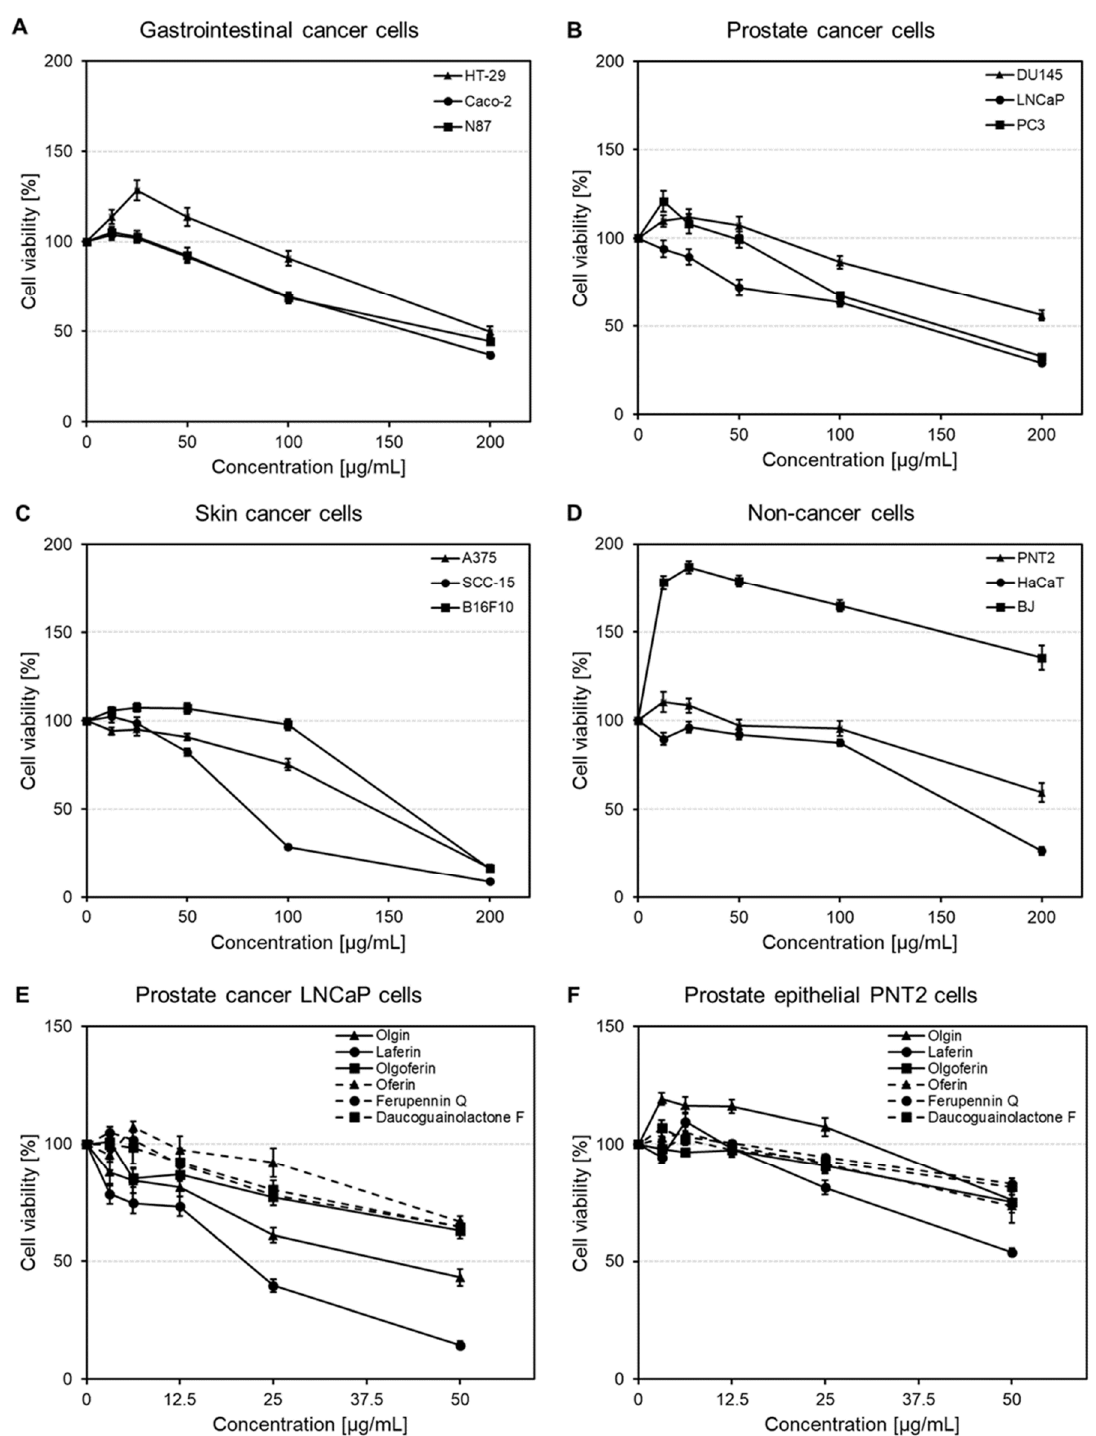
Figure 4. Concentration-response curves showing the effect of Ferula penninervis methanolic root extract against gastrointestinal cancer cells ( A ), prostate cancer cells ( B ), skin cancer cells ( C ) and non-cancer cells ( D ) and the effect of isolated sesquiterpene lactones against prostate cancer LNCaP cells ( E ) and prostate epithelial PNT2 cells ( F ). Cells were seeded in 96 ‐ well plates (3 × 10 3 /well) and treated with increasing concentrations of extract (12.5–200 μ g/mL) or sesquiterpene lactones (3.125–50 μ g/mL); after 48 h, the cell viability was evaluated using neutral red uptake assay. Data are expressed as percentage change in viability in comparison to the vehicle (DMSO) treated control group. Each point represents the mean ± S.E.M. of three independent experiments performed in triplicates.